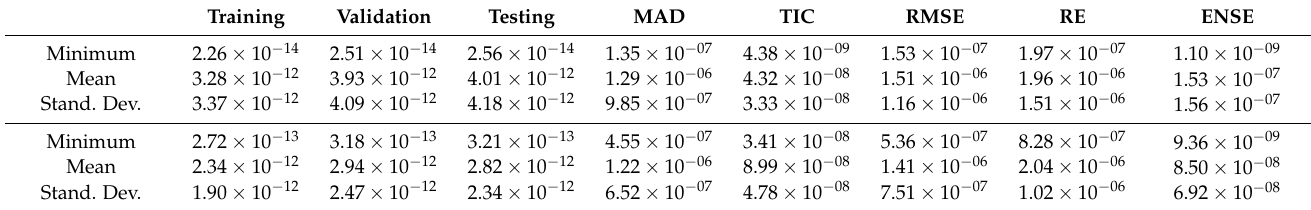
Table 6. Statistical analysis of the values of the validation, testing, and training data along with performance measures computed for the error in the solutions of velocity and acceleration for the micropolar fluid flow with isothermal boundary conditions.